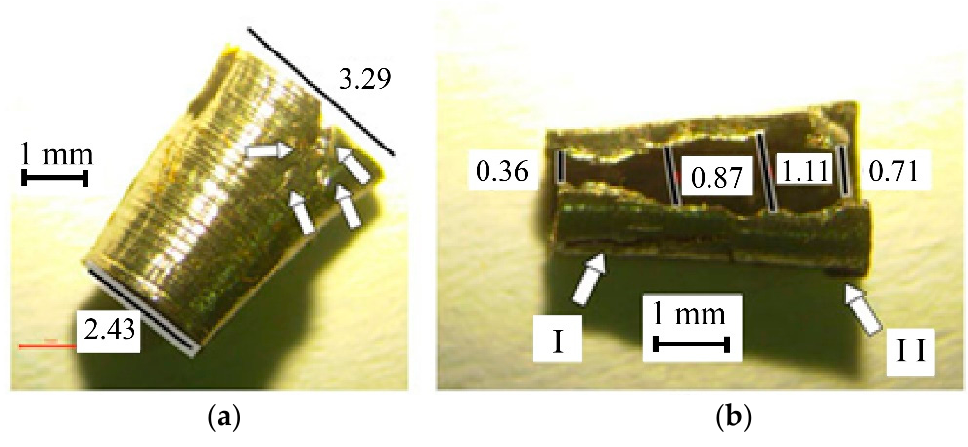
Figure 17. Chips formed during turning with LCLs: outside ( a ); inside ( b ).